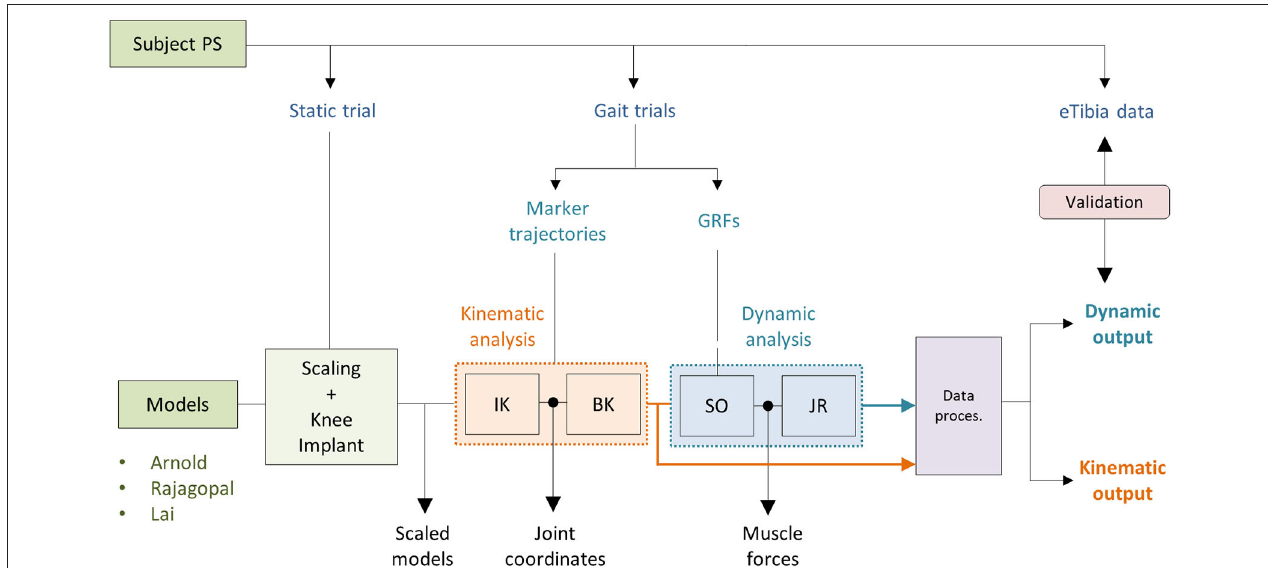
FIGURE 3 | Simulation workflow performed using OpenSim 3.3 and Matlab ®